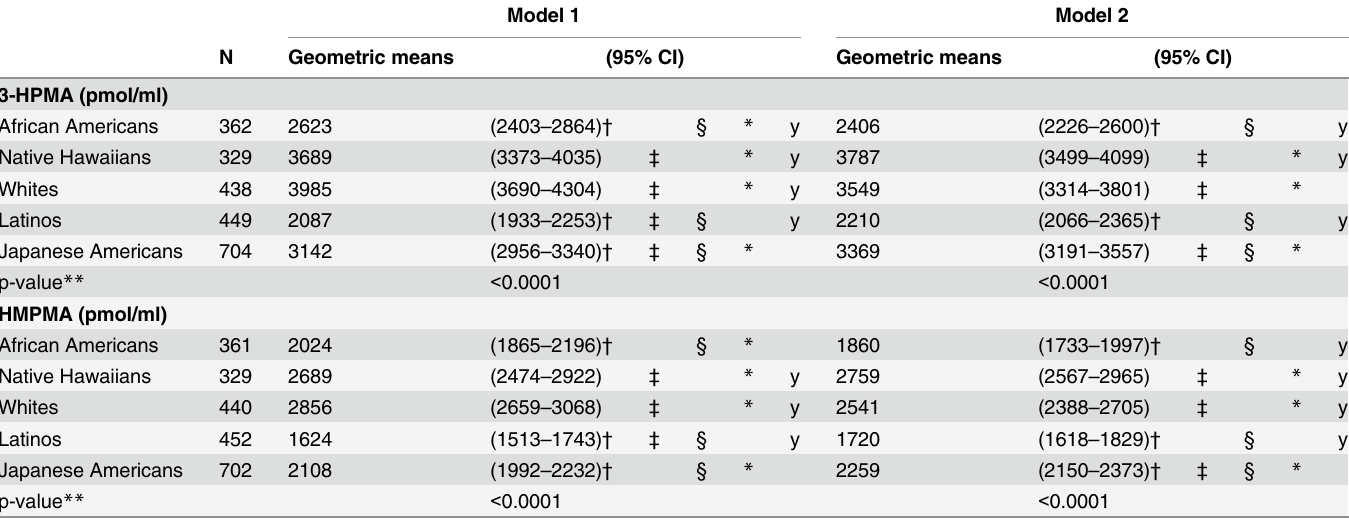
Table 4. Geometric means (95% CIs) of 3-HPMA and HMPMA, stratified by